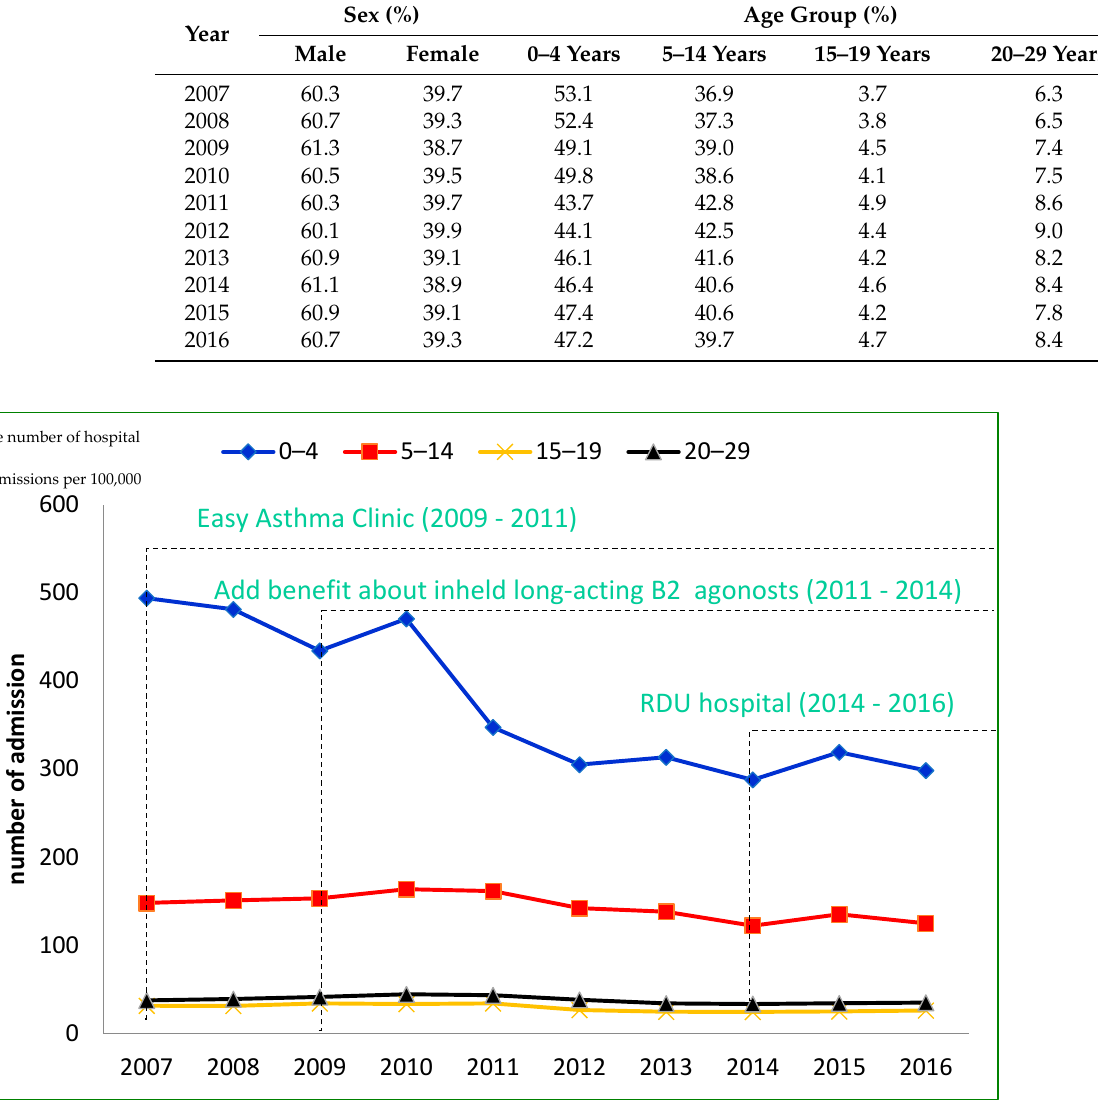
Figure 1. Number of hospital admissions per 100,000 population in different periods of policy change from 2007 to 2016.